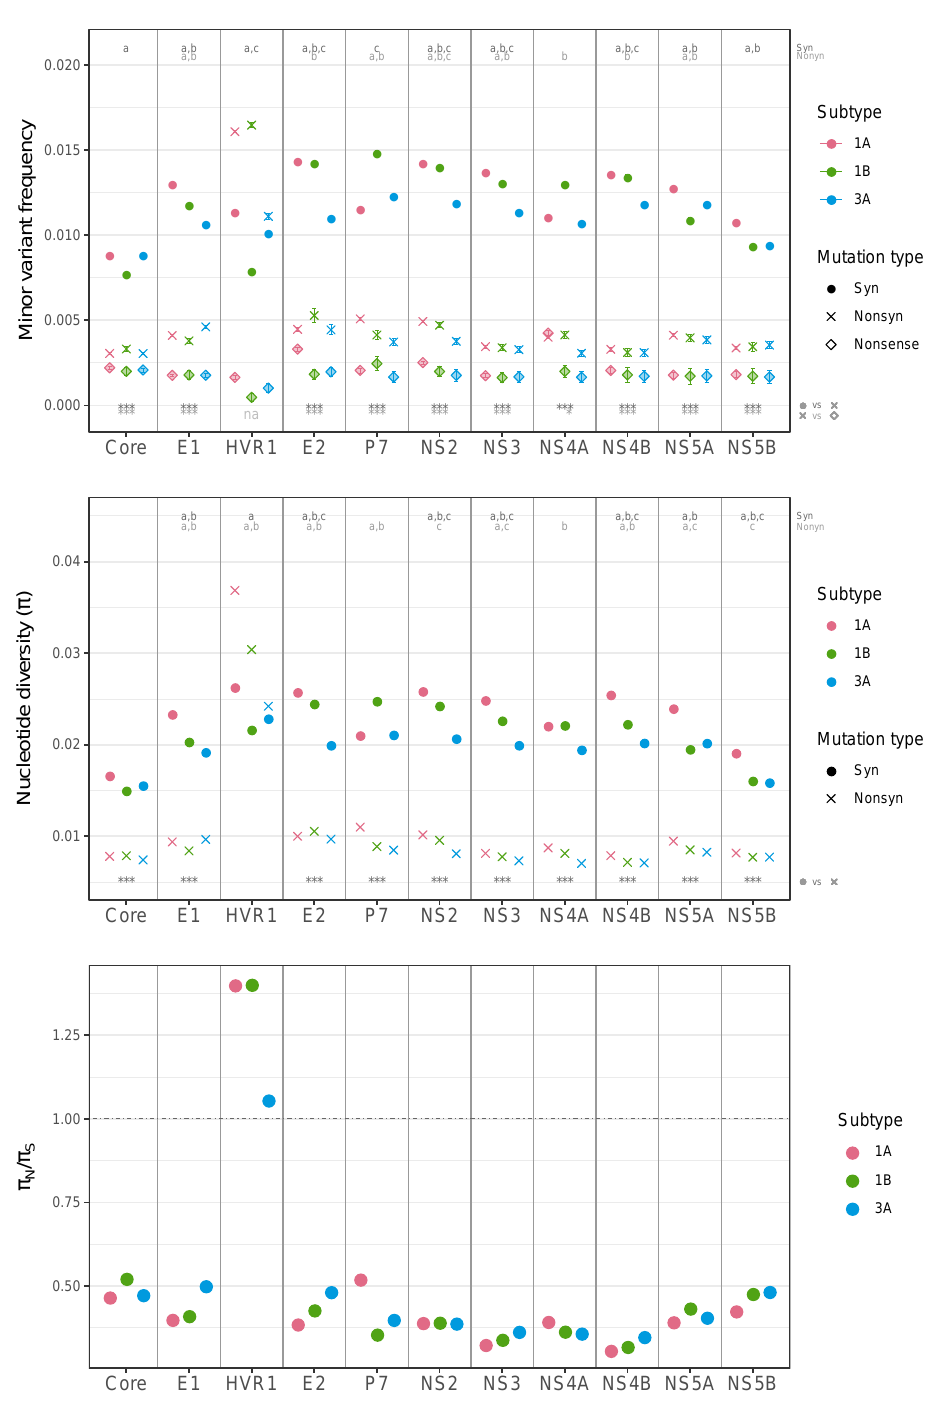
Figure 3. Within-host MVFs of HCV subtype 1a, 1b, and 3a. ( A ) MVFs across the genome with a 100-base rolling average, ( B ) a box plot of MVFs for total, transition, and transversion mutations, and ( C ) a box plot of MVFs per genomic region. Circles in ( B , C ) represent the means with standard errors. Letters on the top in ( A , B ) represent statistically significant differences between subtype 1a and 1b (letter ‘a’), subtype 1a and subtype 3a (letter ‘b’), and subtype 1b and subtype 3a (letter ‘c’). Asterisks (*) on the bottom in ( A , B ) represent a statistically significant difference between mutation types (Synonymous vs. nonsynonymous, nonsynonymous vs. nonsense) within each subtype (1a, 1b and 3a from the